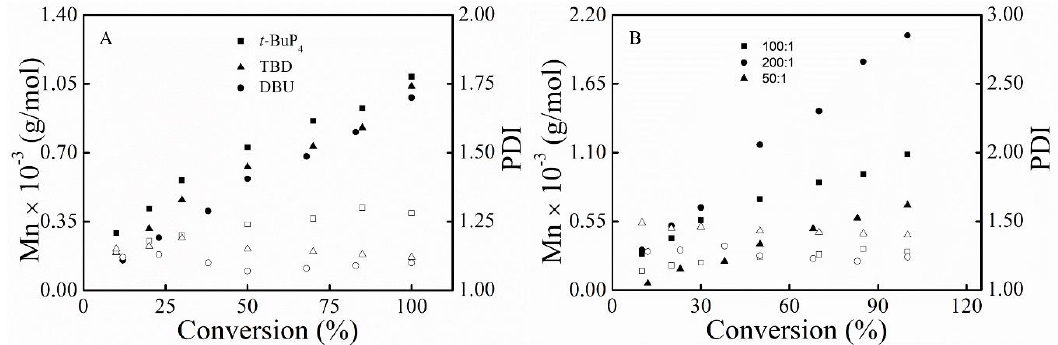
Figure 3. ( A ) M n (solid) and PDI (hollow) versus monomer conversion for the ROP of DXO with t -BuP 4 (square), TBD (triangle) and DBU (circle) as catalysts ([M] 0 /[I] 0 = 100/1); ( B ) M n (solid) and PDI (hollow) versus monomer conversion for different monomer to initiator ratio with t -BuP 4 as catalyst.